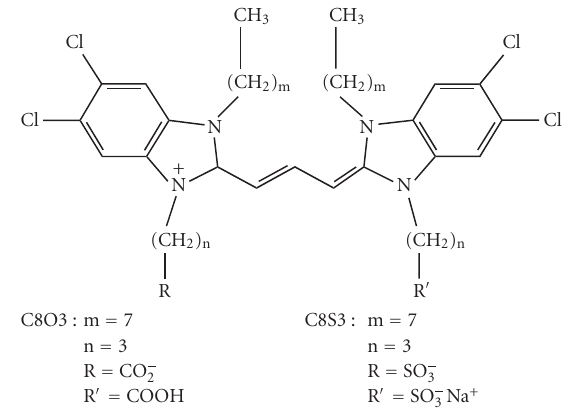
Figure 1: Molecular structure of 5,5 (cid:2) ,6,6 (cid:2) -tetrachlorobenzimida- carbocyanine (TBC) chromophore. The lower part lists 1,1 (cid:2) , and 3,3 (cid:2) nitrogen substituents relevant to C8O3 and